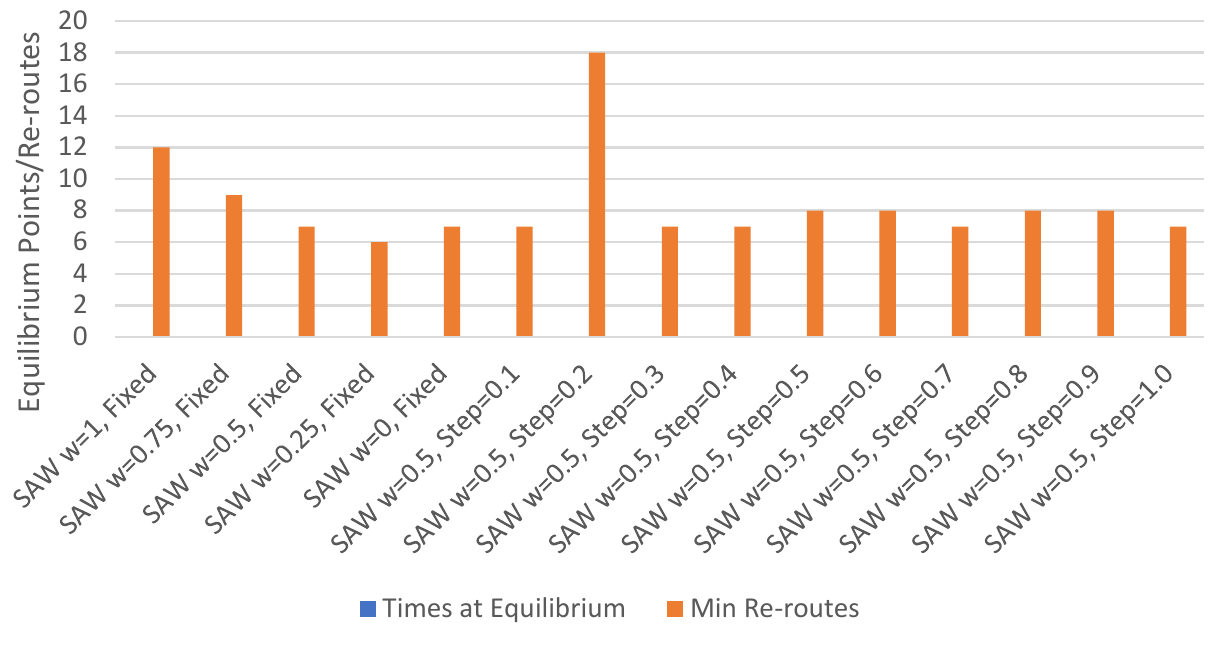
Figure 9. Equilibrium points and re-routes with